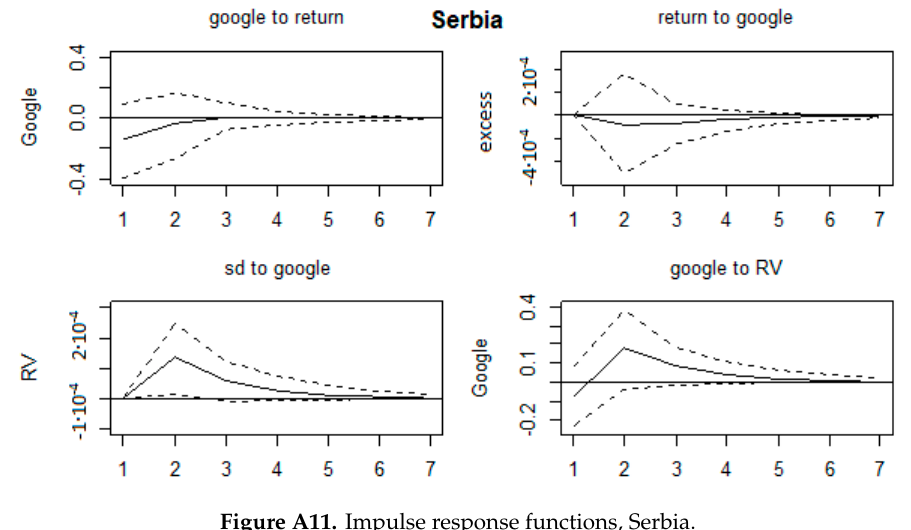
Figure A11. Impulse response functions, Serbia.